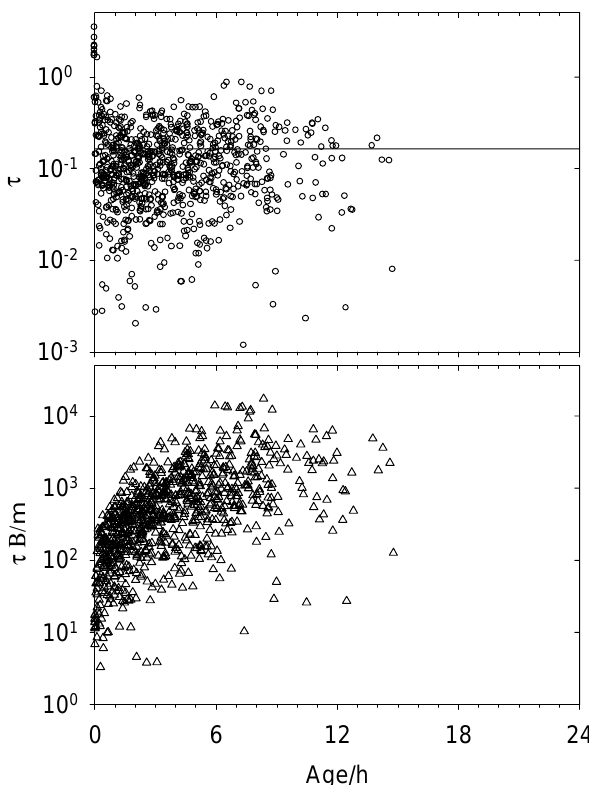
Fig. 10. Top: Optical depth τ at 550nm versus contrail age in a set of contrail segments (as in Fig. 7); the line depicts the mean value (0.164). Bottom: Product τB of optical depth times contrail width B versus contrail